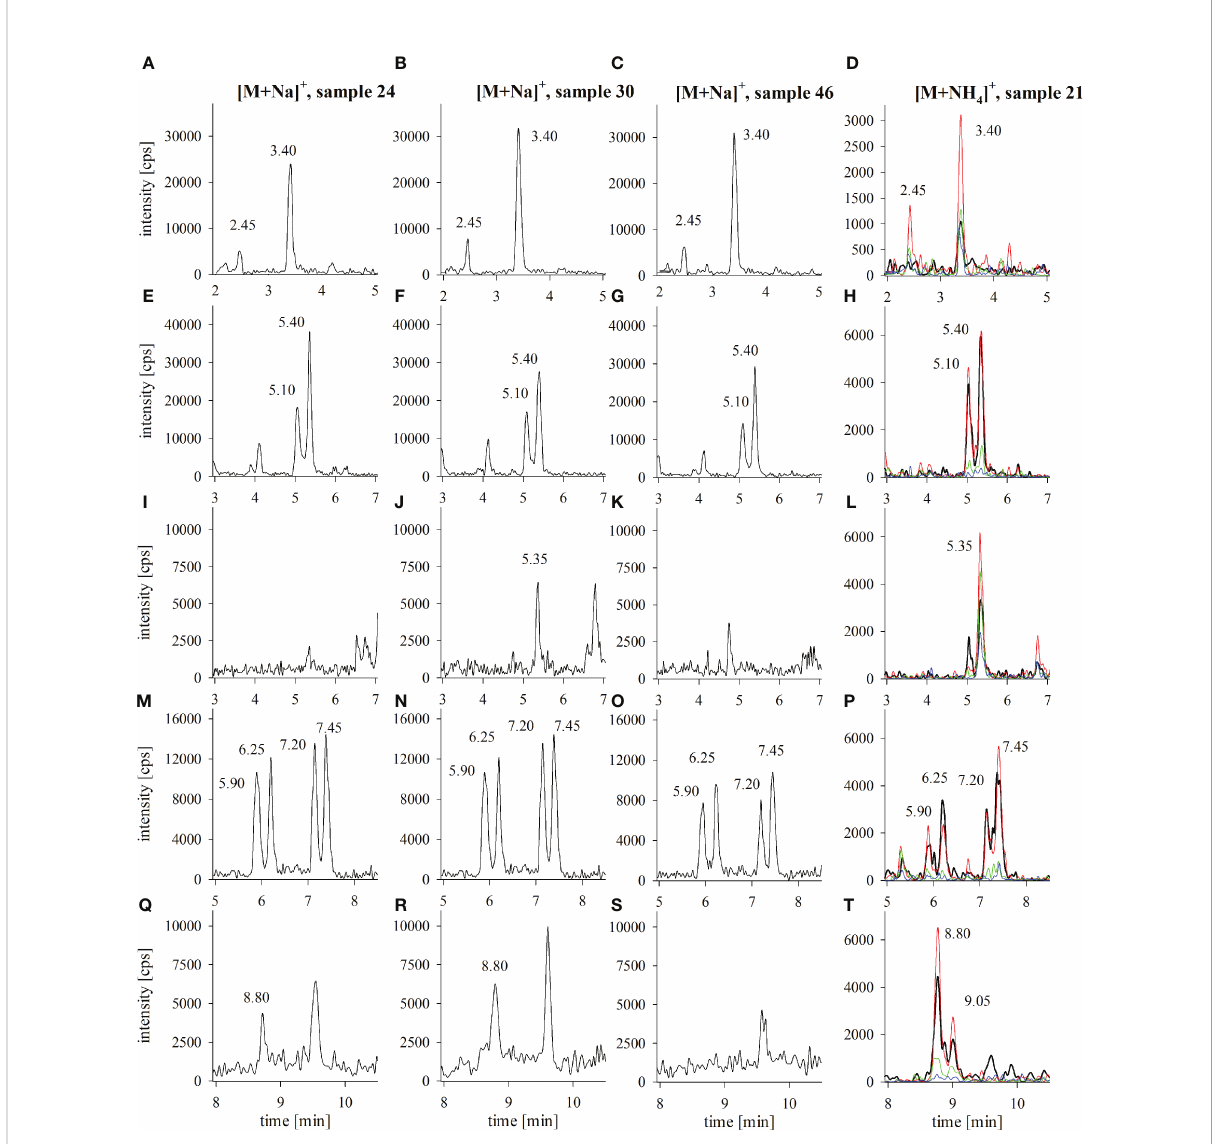
FIGURE 3 LC-MS/MS chromatograms of selected fi sh tissue extracts from the Paci fi c (samples 21, 24, 30) and the Indian Ocean (sample 46); panels show the extracted ion chromatograms for (A-D) 2,3,51-trihydroxyCTX3C (peak at 3.40 min), (E-H) 2,3-dihydroxyCTX3C (5.10 and 5.40 min), (I-L) 51- hydroxyCTX3C (5.35 min), (M-P) M- seco -CTX3C (5.90 and 6.25 min) and 2-hydroxyCTX3C (7.20 and 7.45 min), (Q-T) CTX3C (8.80 and 9.05 min) for the analysis of the sodium adducts (samples 24, 30, 46) and the analysis of the fragments of the ammonium adducts (sample